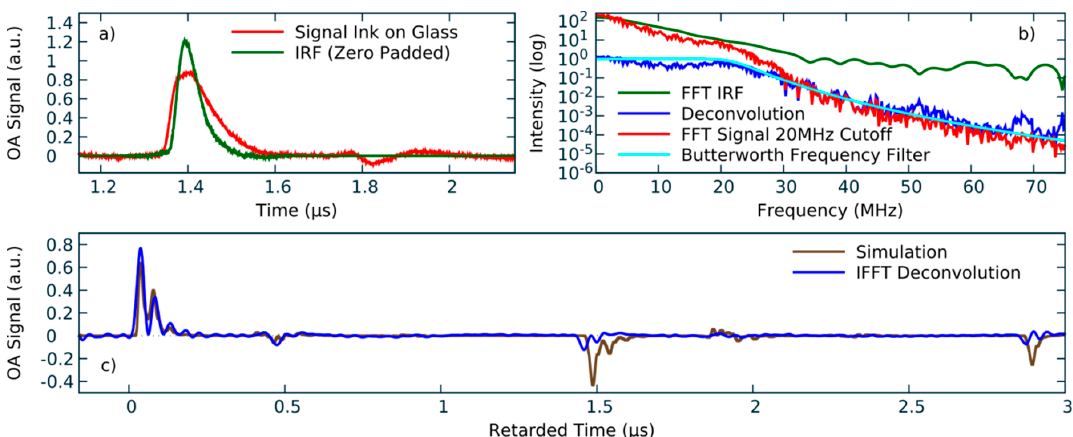
Figure 6. Visualization of post-processing. ( a ) optoacoustic (OA) signal of the instrument response functions (IRF) and ink-on-glass after removal of the pyroelectric signal (green and red). IRF was zero padded to prevent transformation artifacts. ( b ) Frequency spectra of IRF (green) and the ink-on glass-signal with 20 MHz cut-off (red), the Butterworth filter for the 20 MHz cut-off as applied on the signal (turquoise), and the resulting signal after deconvolution (blue). ( c ) Back transformed signal (blue) and 1D simulation (brown) agree well. All features of the signal can be identified.